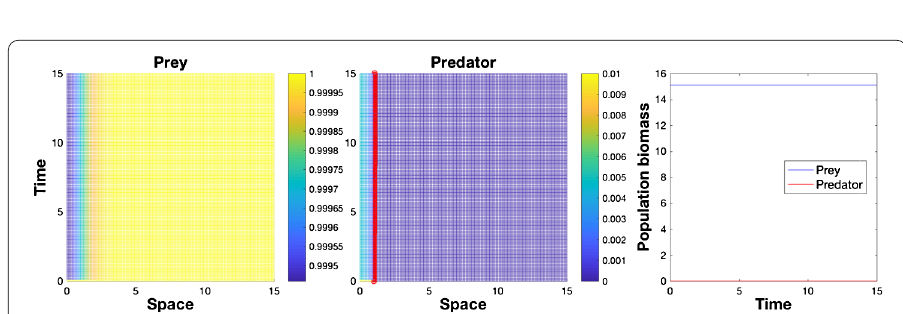
Figure 1 The bigger predator’s attack rate. Graphical illustration of the invasion process of the generalist predator into the native prey species. The left two panels describe the spatio-temporal distribution of population density while the right-most panel shows population biomass. The bold red curve in the middle panel indicates the free boundary. Parameter values are a = 3, b = 4, c = 1, e = 1, h 0 = 1, μ = 0.8.